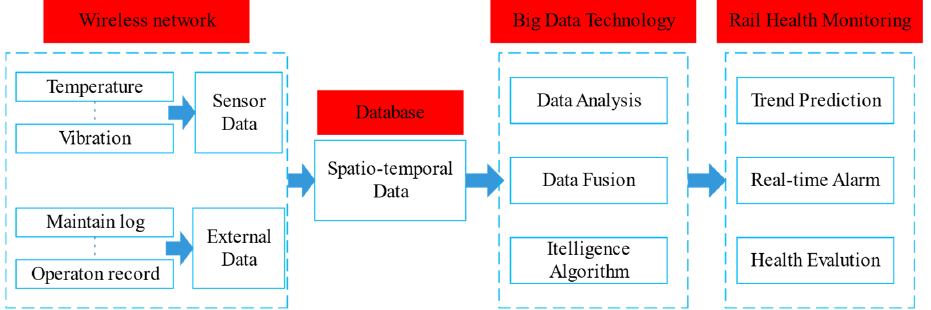
Figure 8. Rail Health Monitoring